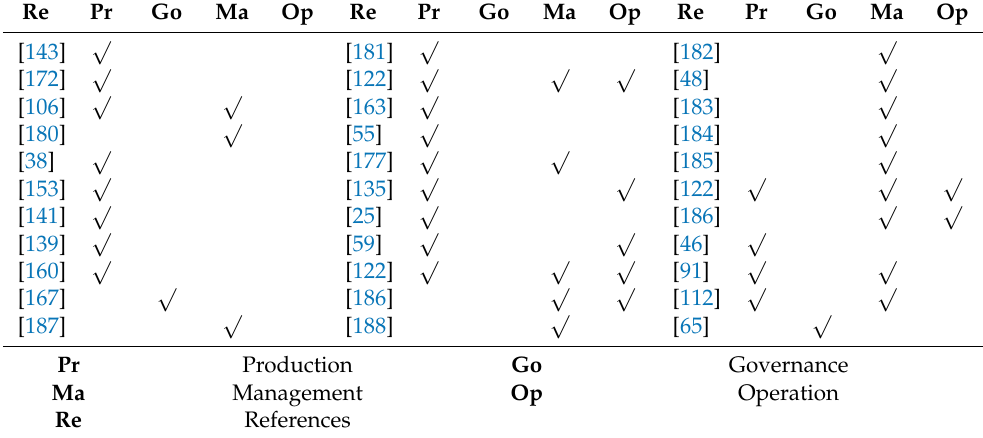
Table 8. Application of blockchain in agriculture for production, management, and